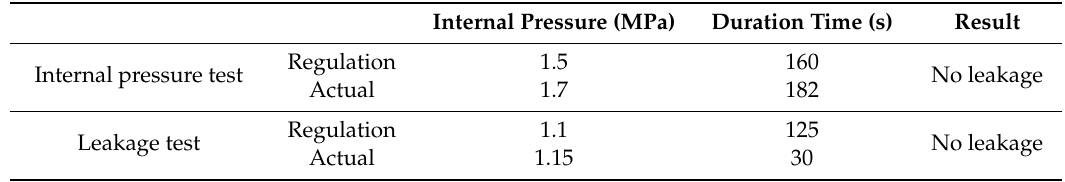
Table 10. Results of performance tests.